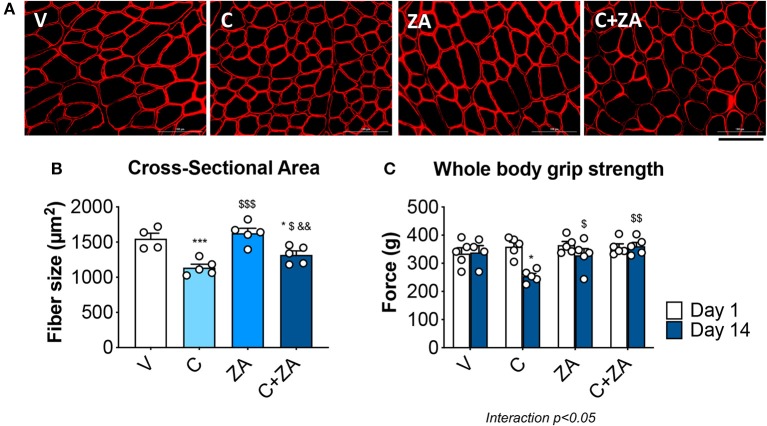
Cisplatin-induced muscle weakness is counteracted by ZA administration. Representative images of immunofluorescence staining for dystrophin (A) and quantification of the cross-sectional area (B) in the tibialis anterior muscle of mice treated with cisplatin and/or ZA (n = 4–5). Scale bar: 100 μm. Whole body grip strength (reported as peak force) was measured at day 1 and day 14 by taking advantage of a grip strength meter and expressed as the average of the three top pulls from each animal (C). Data are shown as means ± SEM. Significance of the differences: *p < 0.05, ***p < 0.001 vs. V; $p < 0.05, $$p < 0.01 vs. C; &&p < 0.01 vs. ZA.